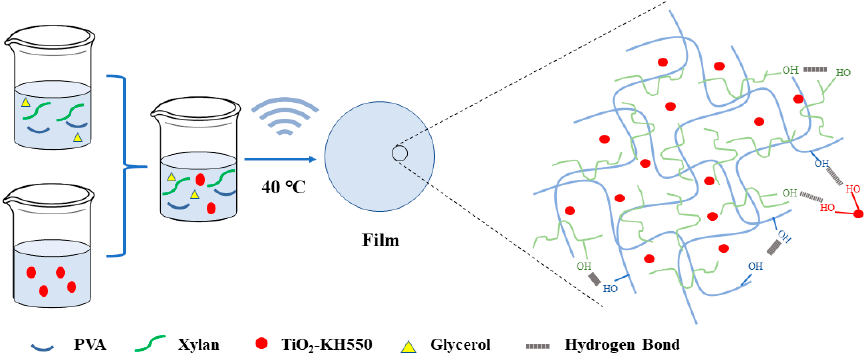
Figure 2. Synthesis process of composite films.